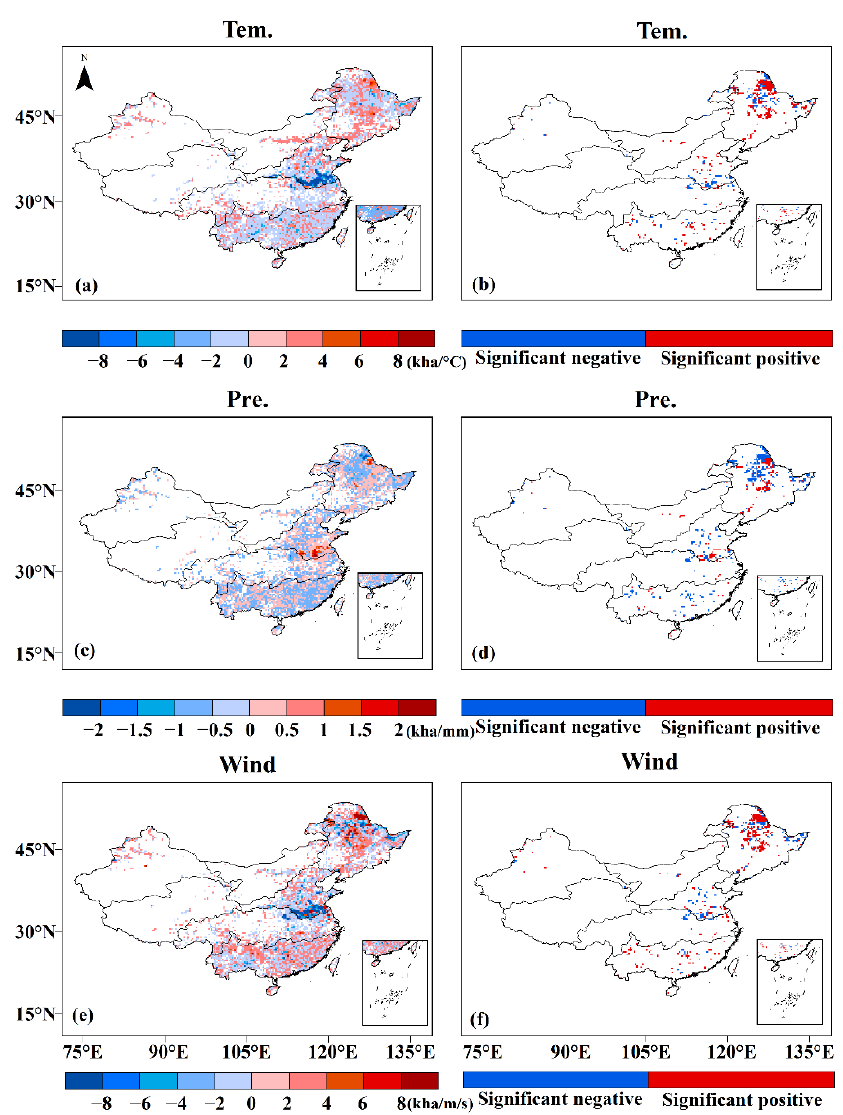
Figure 11. The coefficients of the multivariable regression equations between BA and three climatic factors (i.e., temperature, precipitation and wind speed) at annual scale. The left column shows all points, and the right column shows the corresponding significant points ( p < 0.1): ( a , b ) represent temperature; ( c , d ) represent precipitation; ( e , f ) represent wind speed.